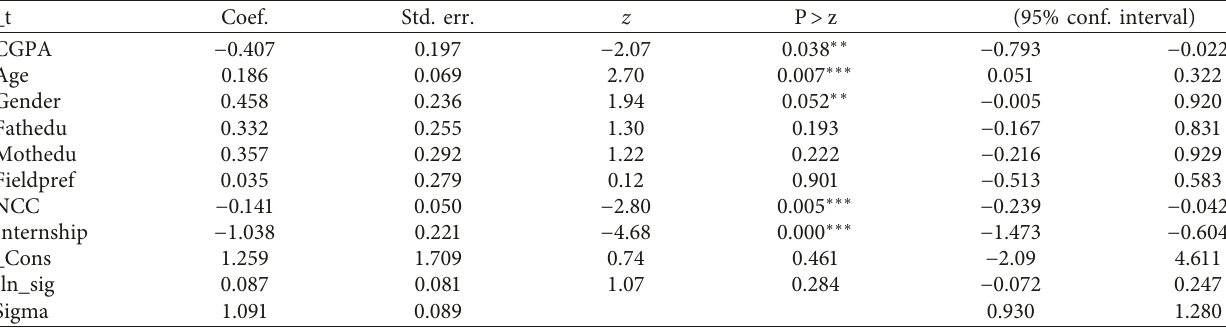
Table 9: Lognormal regression result accelerated failure-time form.